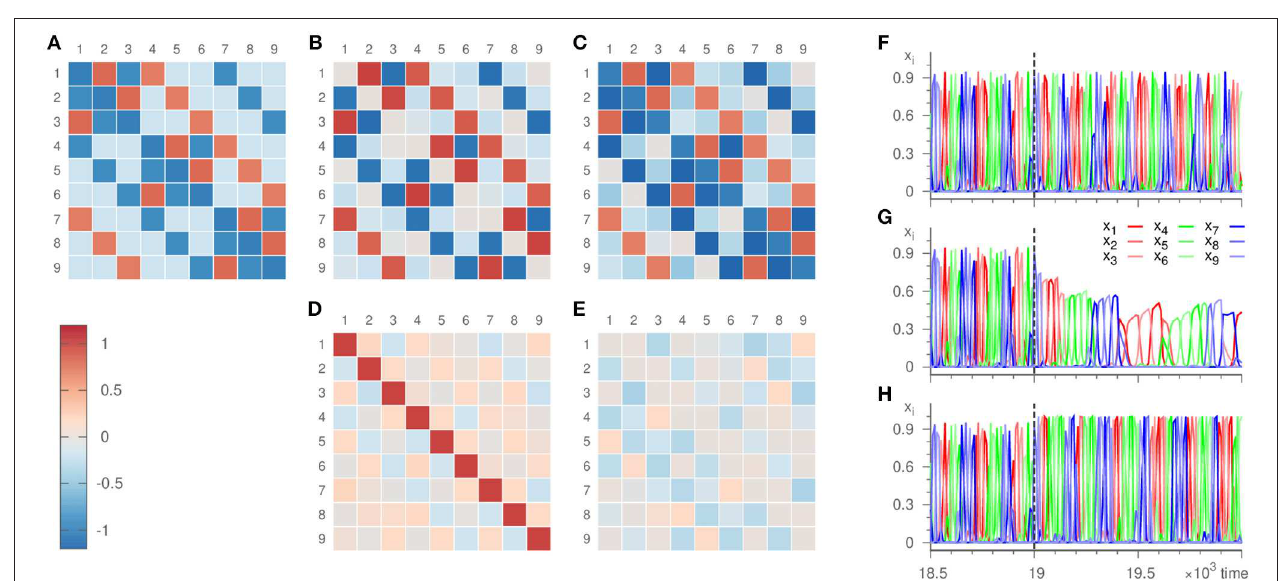
FIGURE 6 | Eigenvalues a i , j and dynamics of the hierarchical heteroclinic network H . Panel (A) depicts the original values, (B) the values inferred with parameters ϑ 10, γ 20, ρ 0.001, σ 10 − 6 where a i , j 0 initially, and (C) the values inferred with parameters ϑ = = = = = inference was realized over 19 10 3 time units. The lower panels show the error of the inference, i.e., (D) the difference of panels (B,A) , (E) the difference of panels × (C,A) . The remaining panels display the dynamics at the end of the inference process plotted against time. Panel (F) shows the input signal, (G,H) the dynamics of the templates that resulted in (B,C) ,